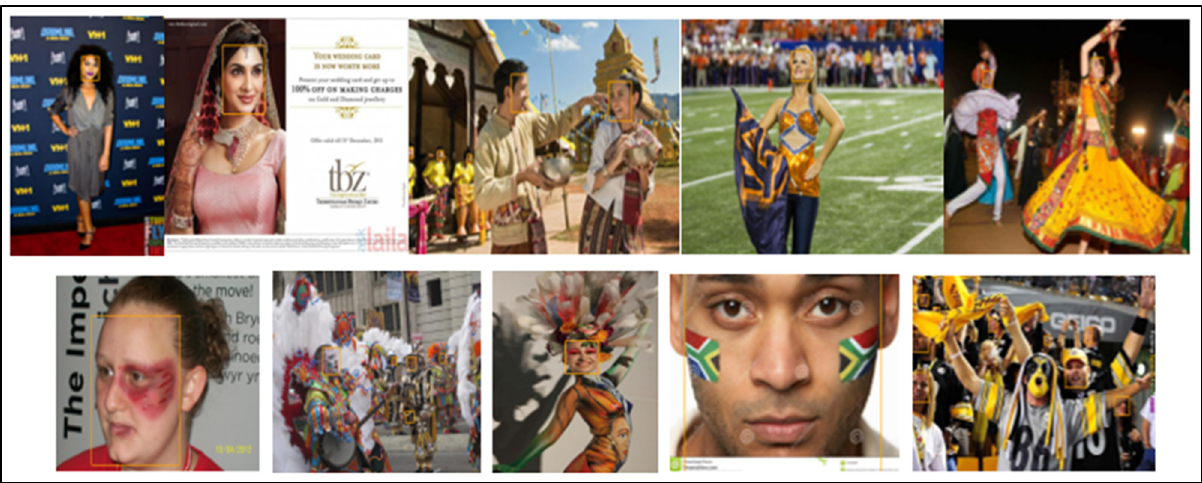
Figure 4. Makeup image results (WIDER FACE dataset).